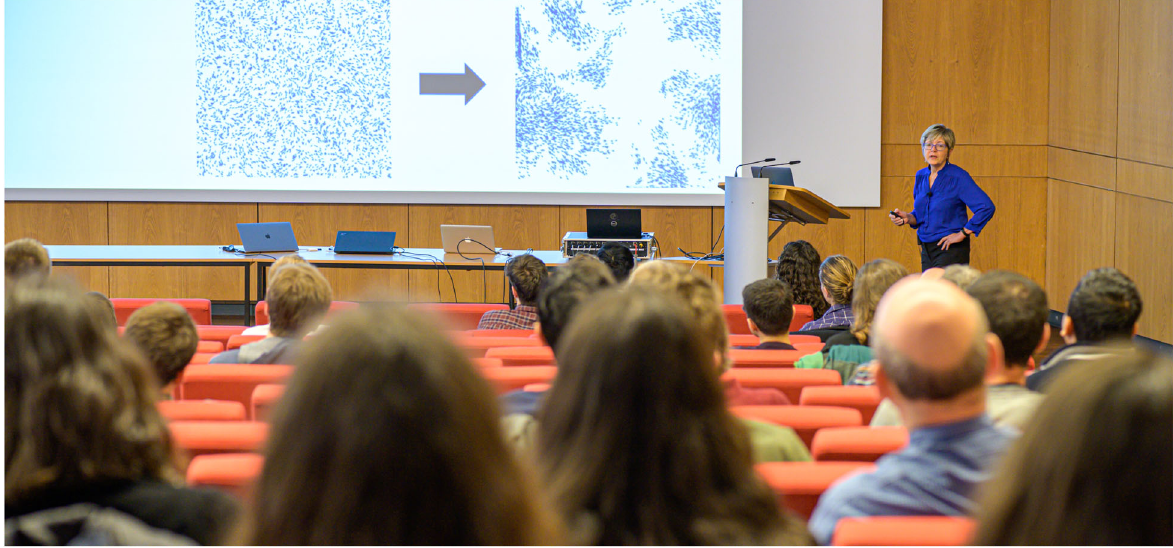
Fig. 2 Keynote lecture by M. Cristina Marchetti on The Physics of Active Matter. “ This is the fi rst time I have attended a conference organized